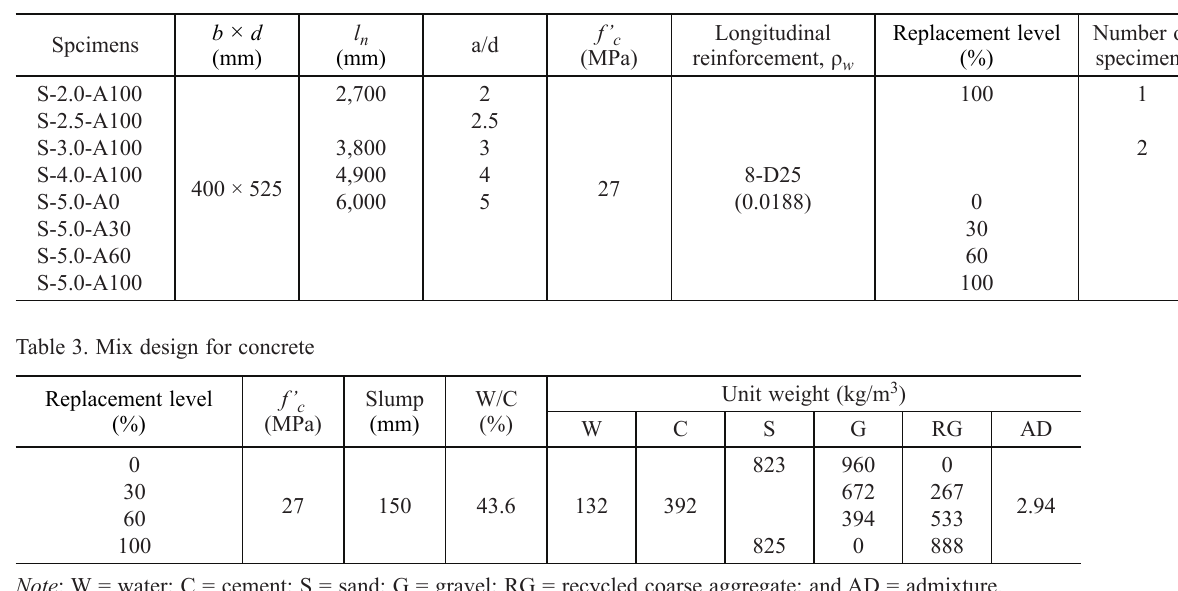
Table 2. Test matrix for beam specimens